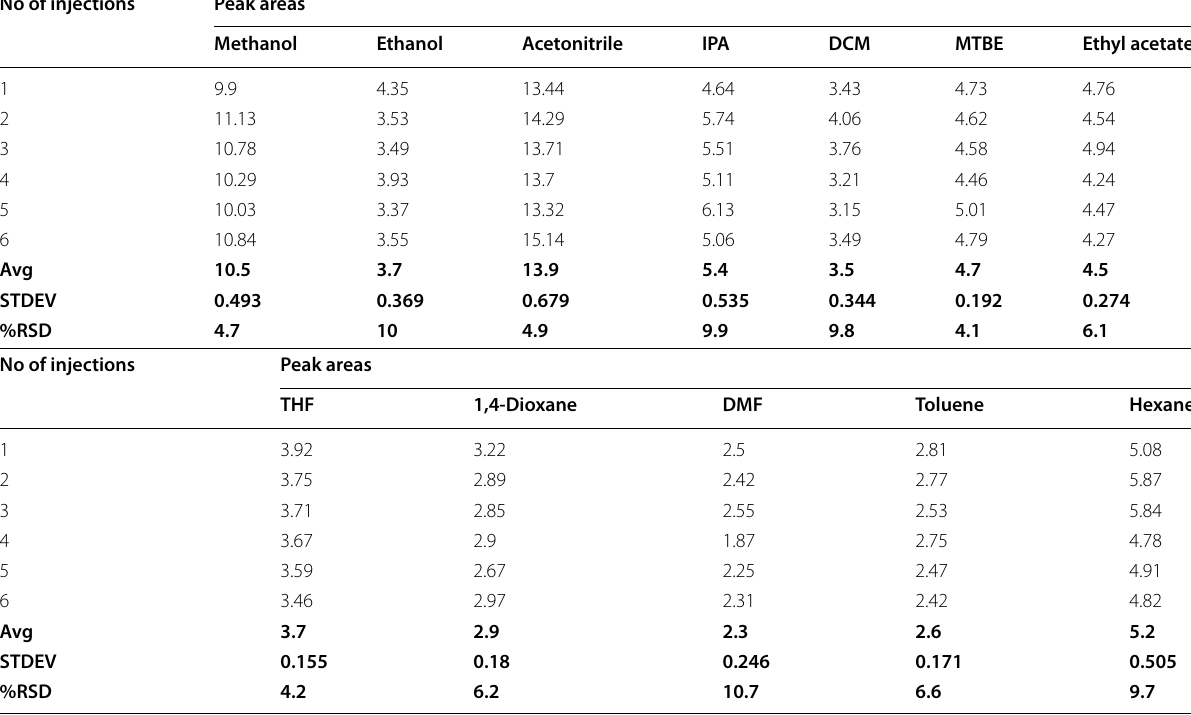
Bold values indicate better results than other filtering